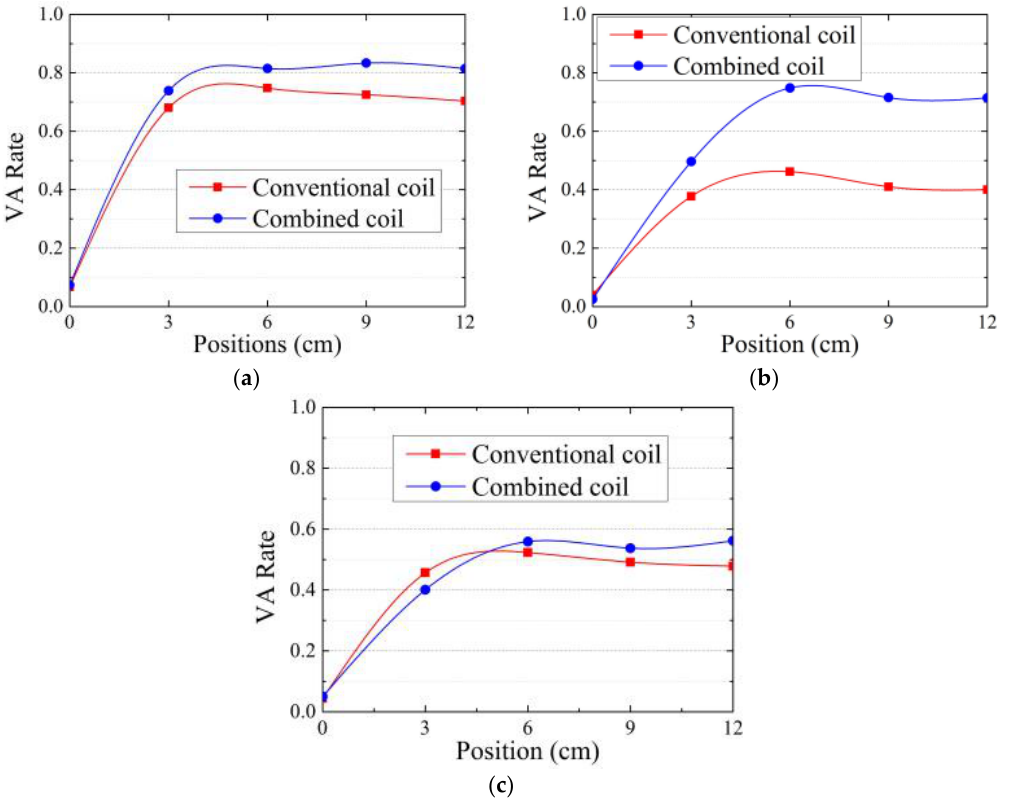
Figure 12. Measured VA rate of the transmitting circuit under different loads. ( a ) Load of 5 ohm; ( b ) Load of 7 ohm; ( c ) Load 10 of